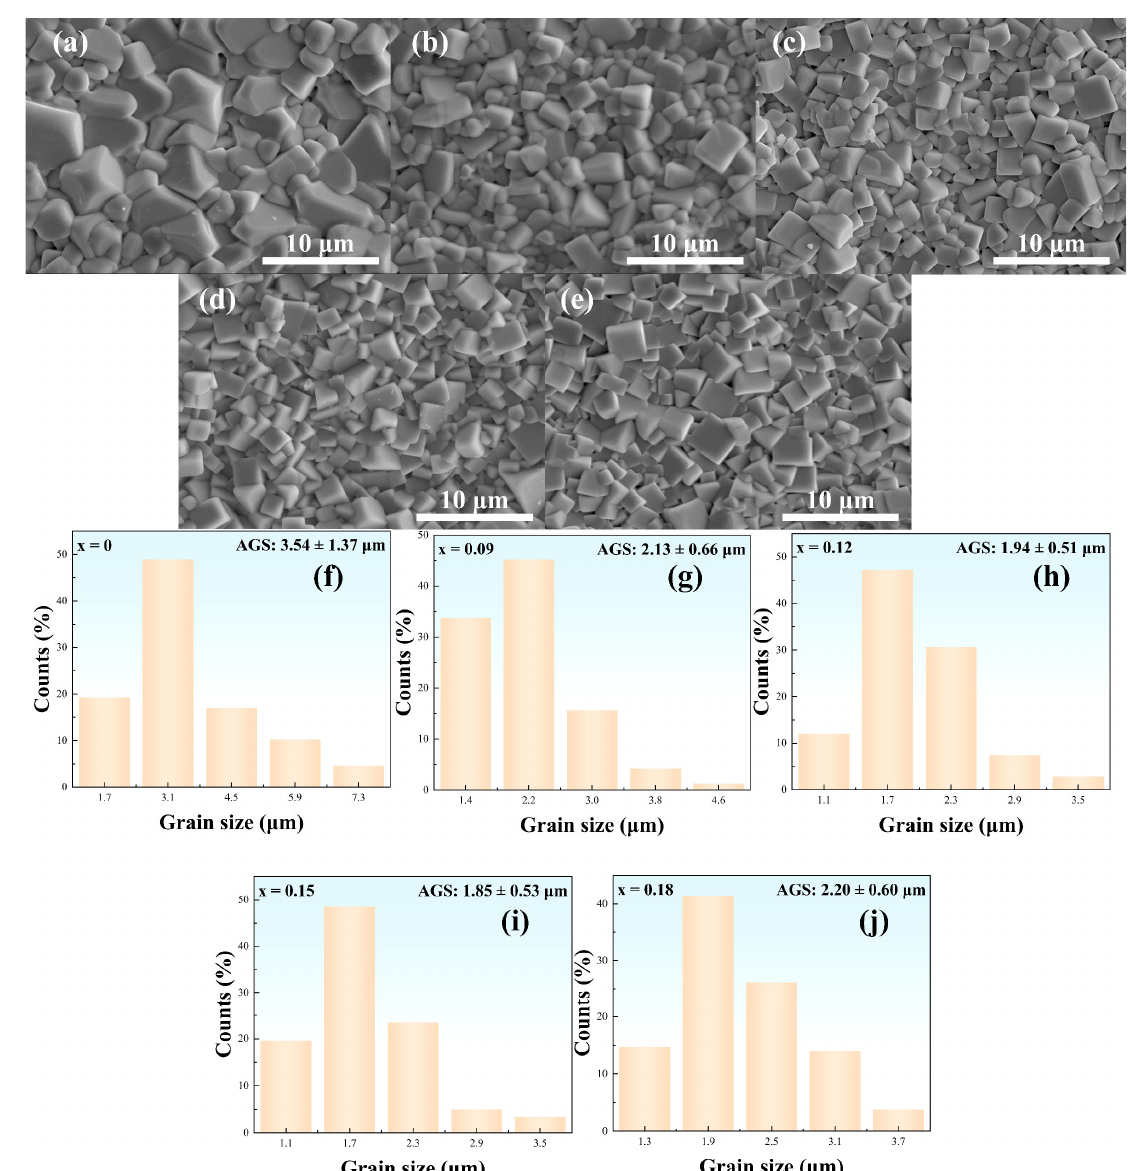
Figure 2. Surface morphologies of NBT-SBT-xBMZ ceramics. ( a – e ) Scanning electron microscope (SEM) images of various compositions; ( f – j ) the corresponding statistics of grain size distributions of the SEM images ( a – e ).